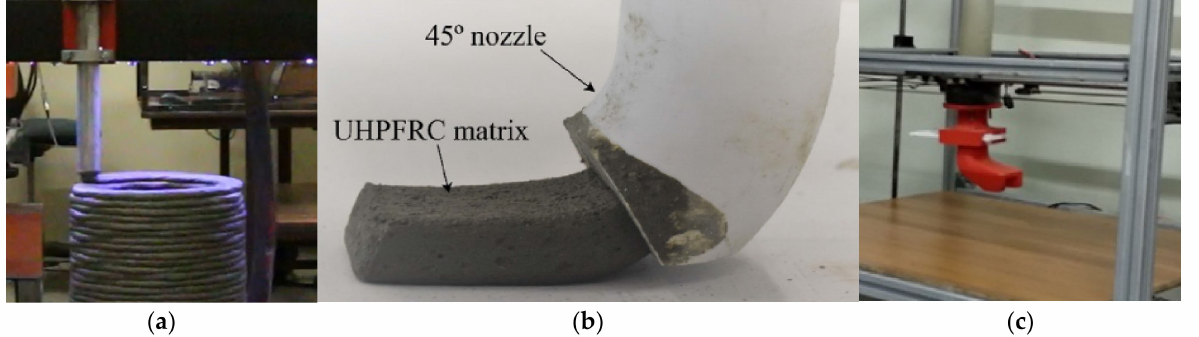
Figure 9. Nozzle tips in different angles to the horizontal line, reprinted with permissions: ( a ) 90 degree [10], ( b ) 45 degree [8], and ( c ) zero-degree [53].